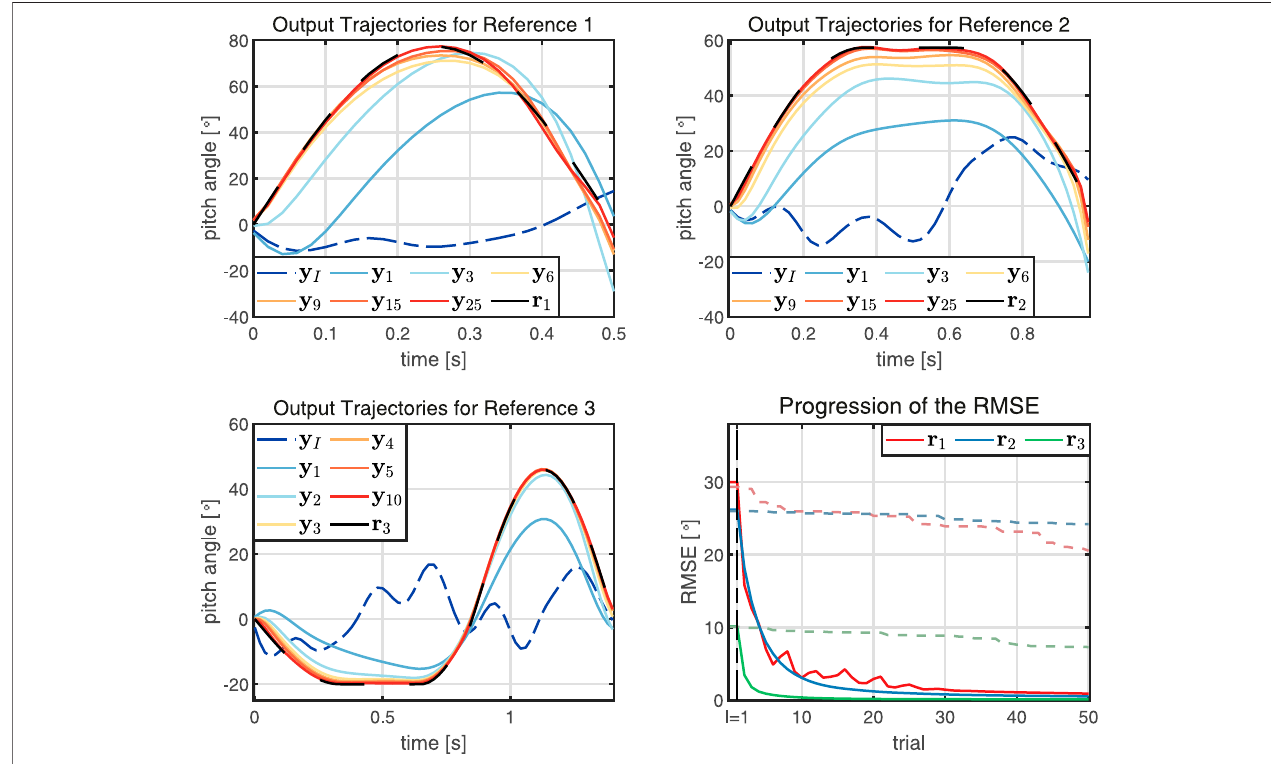
FIGURE 8 | The proposed learning method is employed to track the three desired references. Despite varying lengths, amplitudes and frequencies of the references,satisfyingtrackingperformanceisachievedwithin10 – 15trials.TheRMSEismonotonicallydecliningfortwoofthereferencesand convergestoasmallvalue close to zero in all three scenarios. To provide an additional baseline, the dashed lines in the RMSE plot show the performance of a generic reinforcement learning method, which learns magnitudes slower.